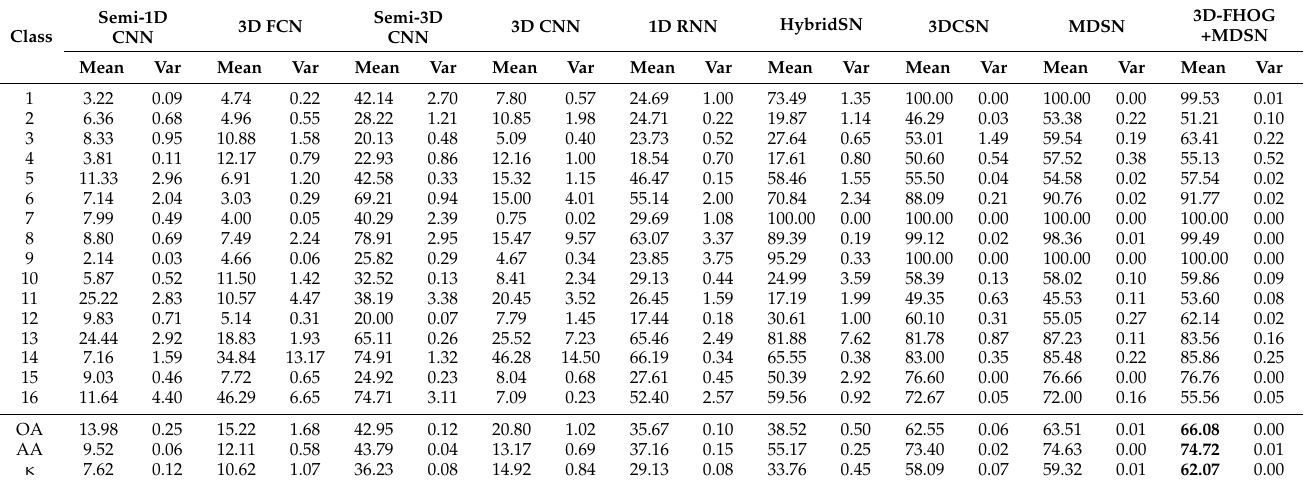
Table 8. Classification results (%) for eight different CNN-based methods and 3D-FHOG + MDSN on the test set of IP data set, with three labeled samples per class as training